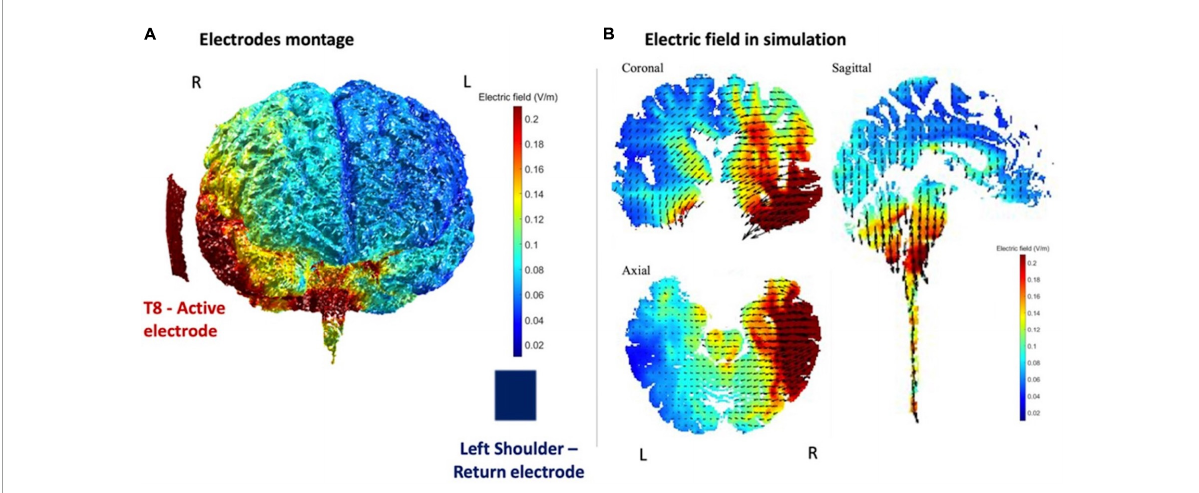
FIGURE1 ROAST (realistic volumetric approach to simulate transcranial electric stimulation, Huang et al., 2019) simulation of electric field magnitude in T8 anode (active electrode) and in the place nearest to the contralateral shoulder cathode (return electrode) stimulation setup. (A) Electrode montage and (B) electric field magnitude simulation in axial, coronal, and sagittal planes. Taken from Reyes et al.